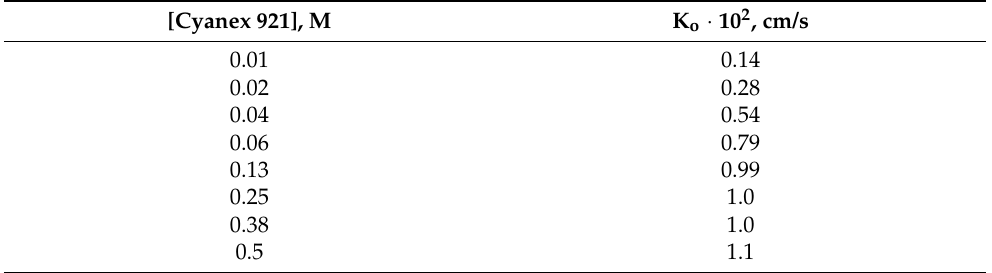
Table 2. Transport of Cr(VI) at various Cyanex 921 concentrations in the membrane phase. [Cyanex 921],